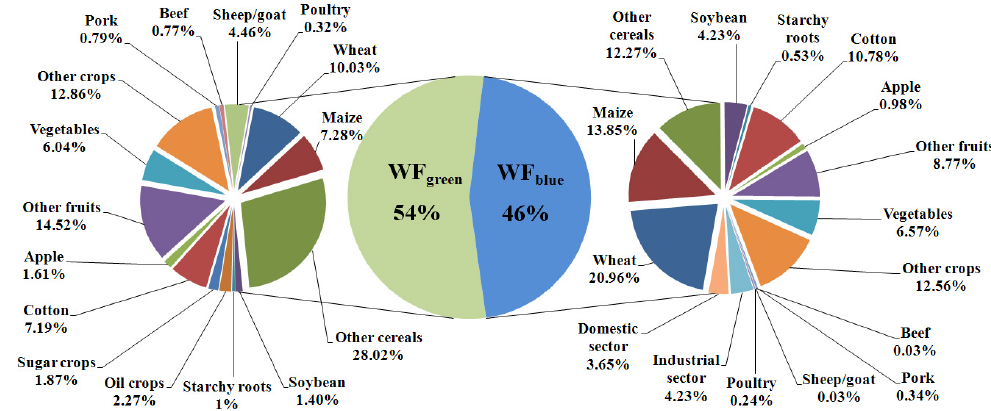
Fig. 7. Average annual green and blue water footprint (WF green and WF blue ) within the HRB over 2004–2006.